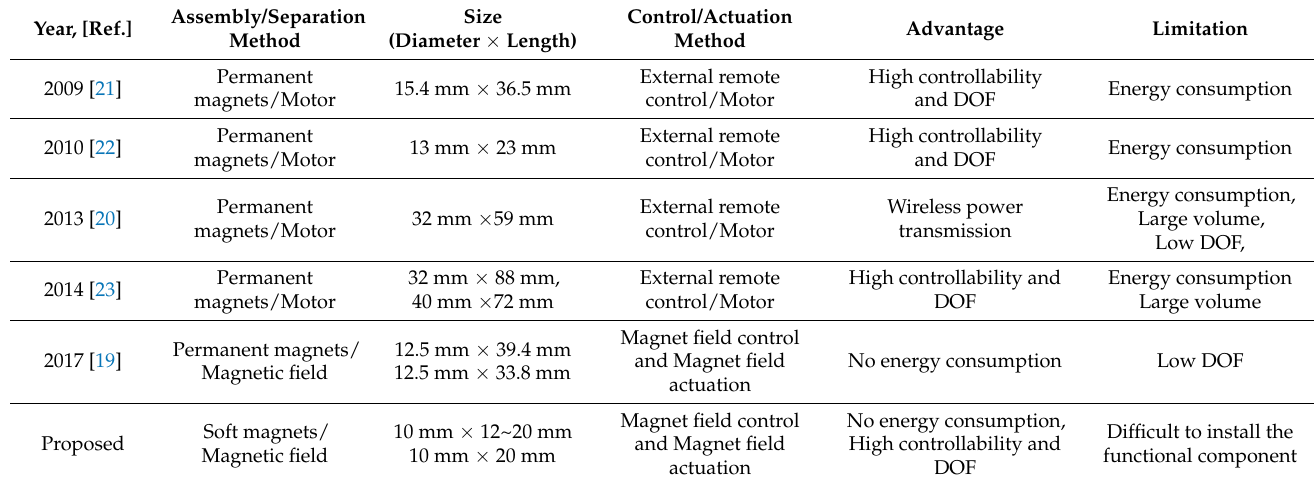
Table 1. Comparison of modular capsule